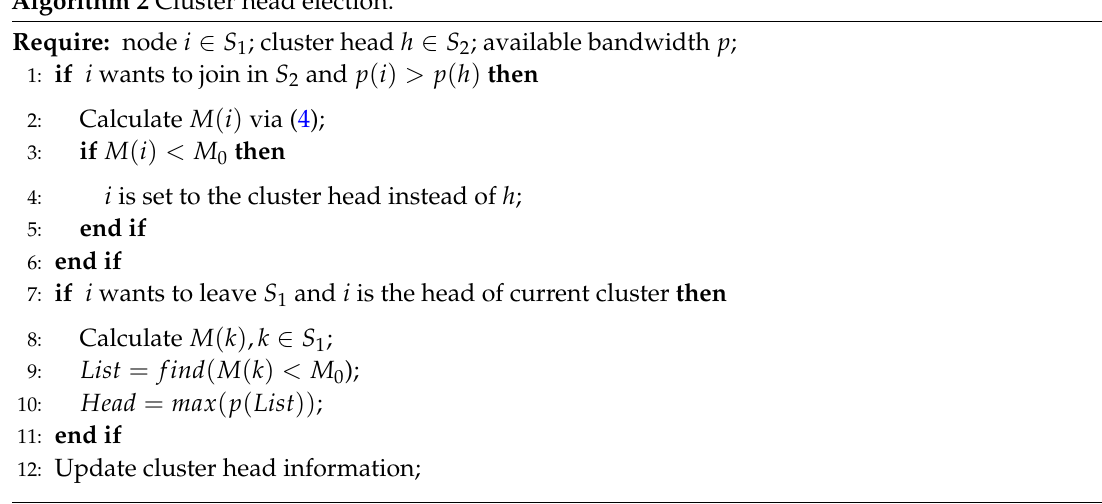
Algorithm 2 demonstrates the details of the cluster head election algorithm. Algorithm 2 Cluster head